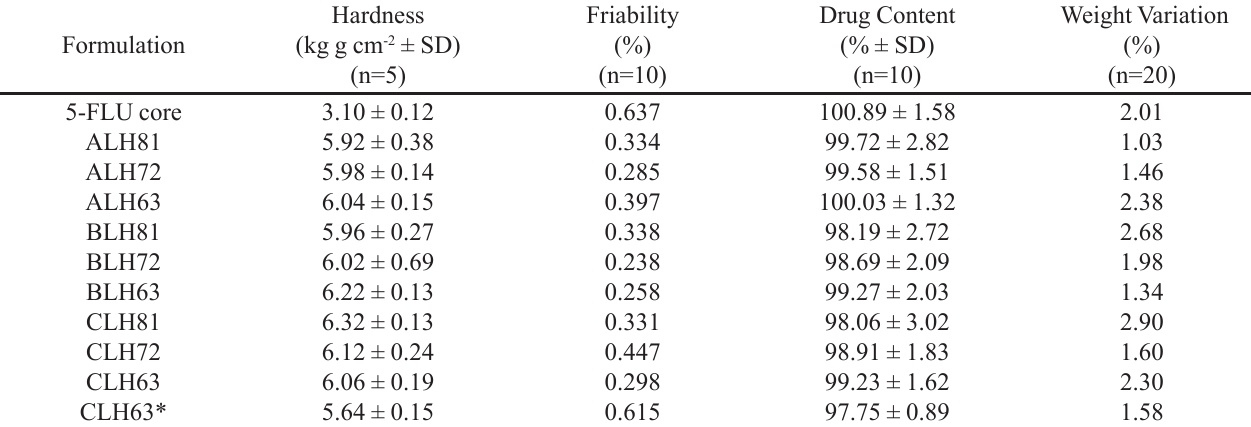
TABLE III - Physical evaluation study for 5-fluorouracil core and compression coated tablets